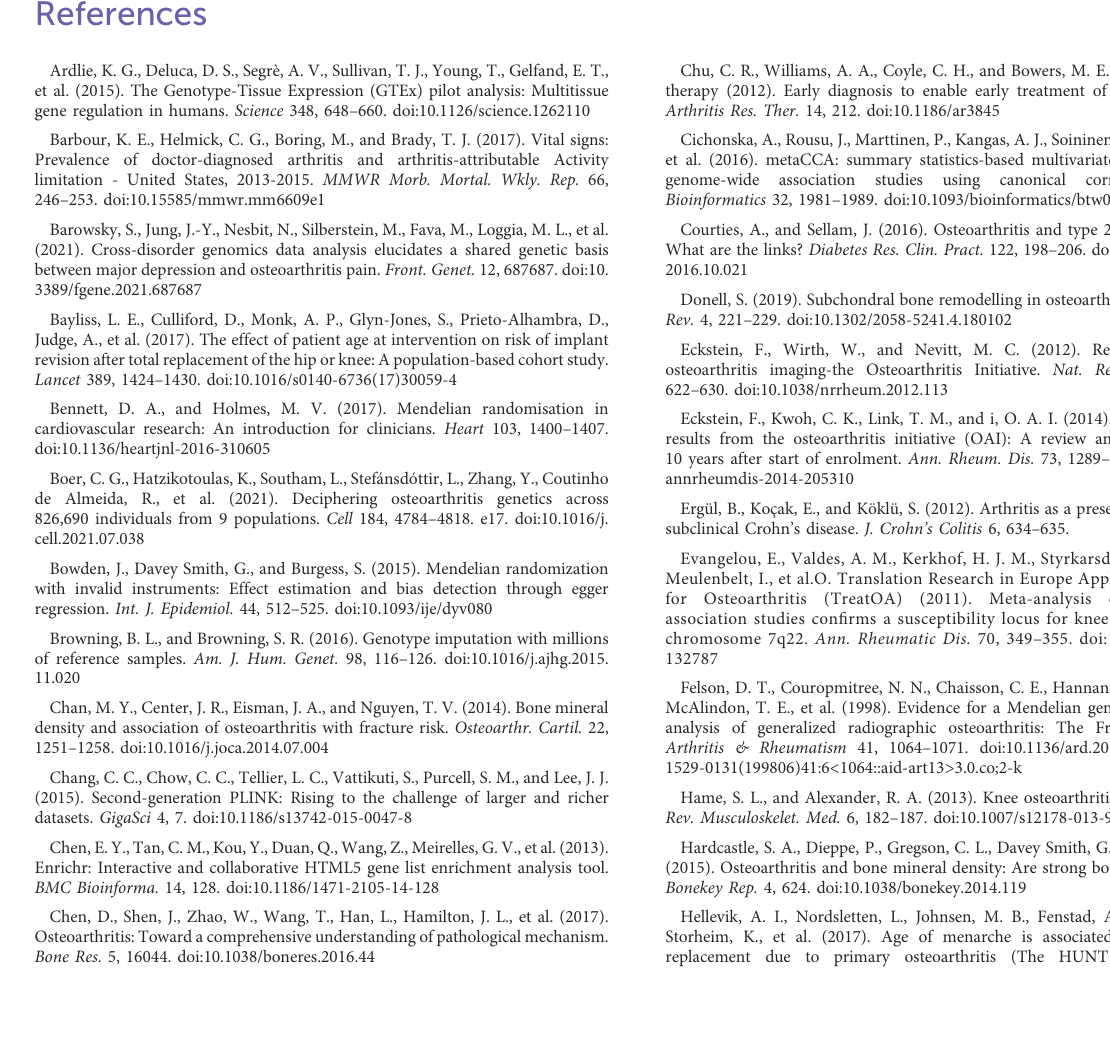
SUPPLEMENTARY FIGURE S2 LocusZoom for signi fi cant signals for GWAS results ( – log10 ( p value)) for genotyped SNPs are plotted against genomic position. The circles indicate association results of genotyped SNPs in the region; the color re fl ects the correlation coef fi cient (r2) of each genotyped SNP in 1000 Genomes Project